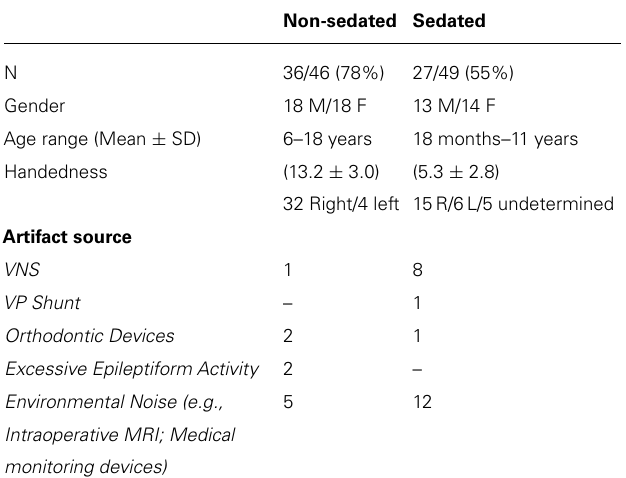
Table 2 | Profiles of non-sedated and sedated patients included in final analysis and rationale for exclusion of cases not considered for laterality assessment.